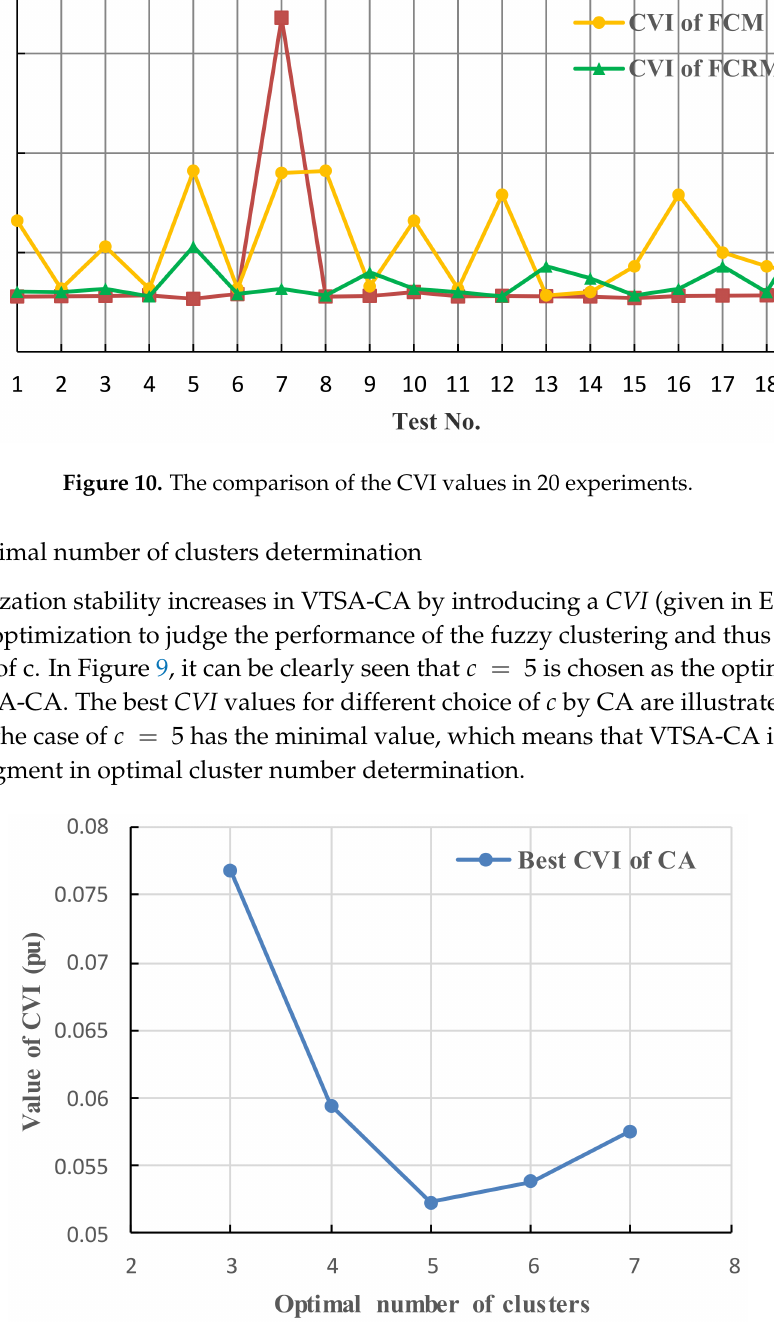
Figure 11. Relation between CVI and number of